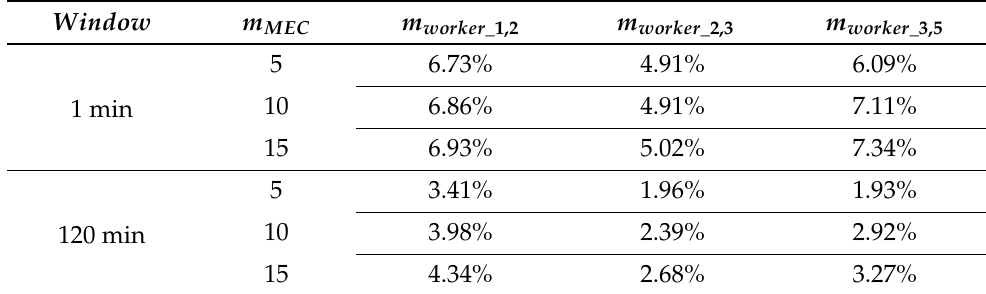
Table 2. Influence of the parameter m worker on the total savings.